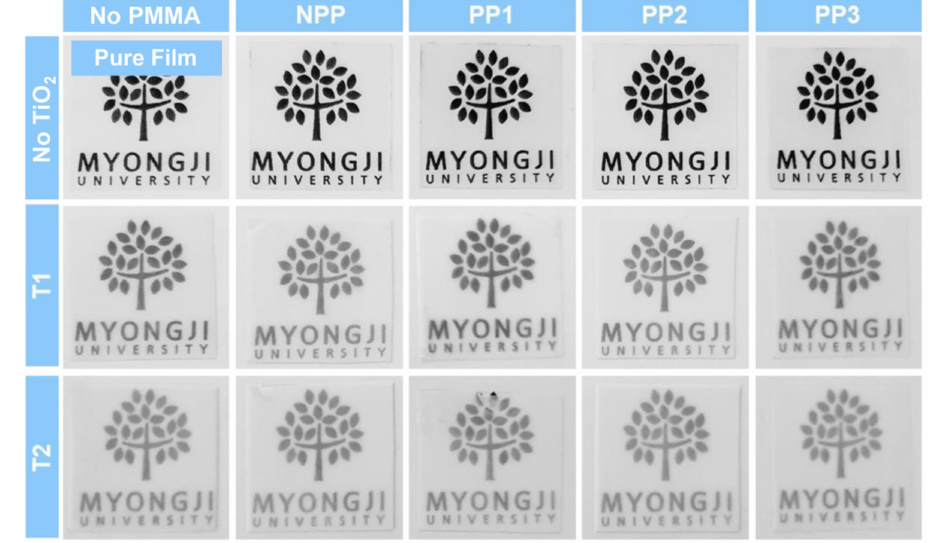
Figure 6. Photographs of the pure thin film and thin films with only PMMA, only TiO 2 , and hybrid